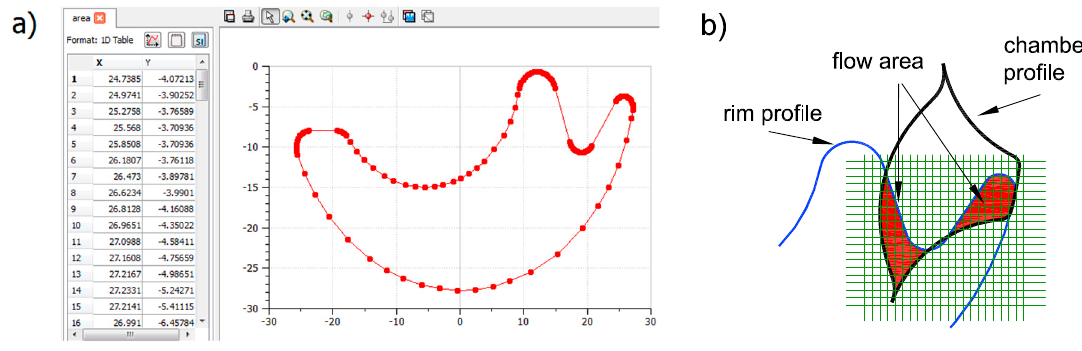
Figure 19. ( a ) Complex profile of the suction port of a gerotor pump defined numerically; ( b ) discretization of the domain for the evaluation of the flow